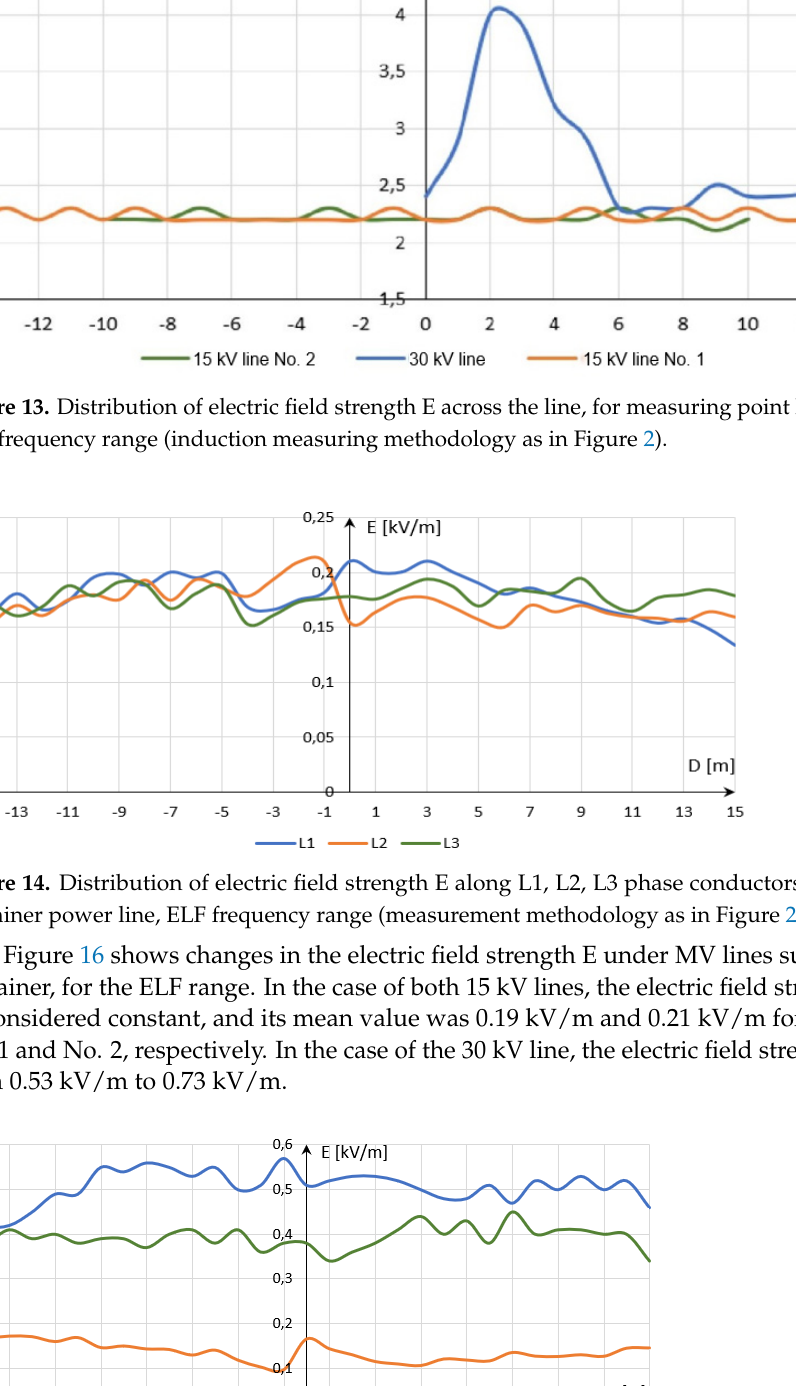
Figure 15. Distribution of electric field strength E along L1, L2, L3 phase conductors of the 30 kV container power line, ELF frequency range (measurement methodology as in Figure 2).